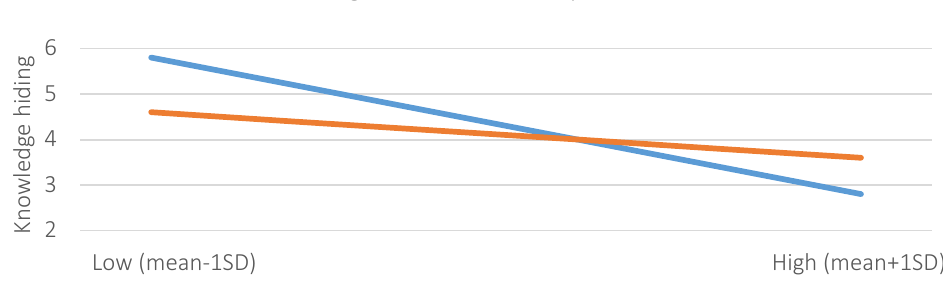
Figure 2. Moderating effect of